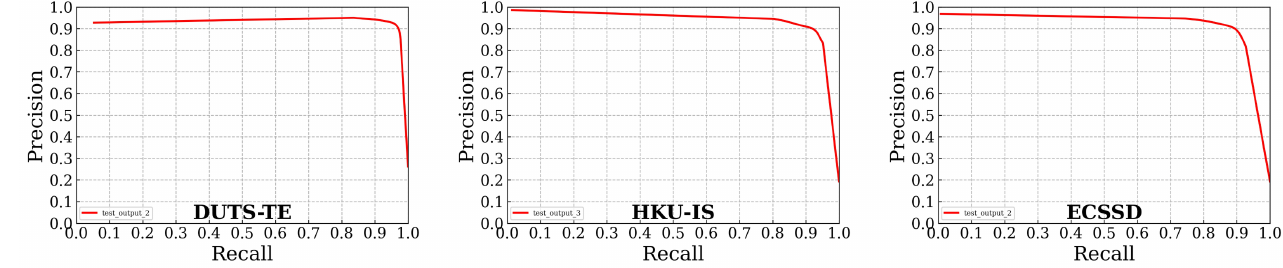
Figure 3. Precision-recall curves generated by the proposed Revise-Net model on DUTS-TE, HKU-IS, and ECSSD